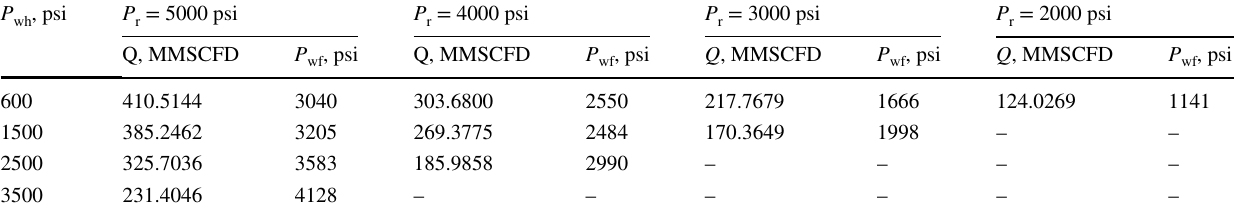
Table 11 Operating points through reservoir simulation